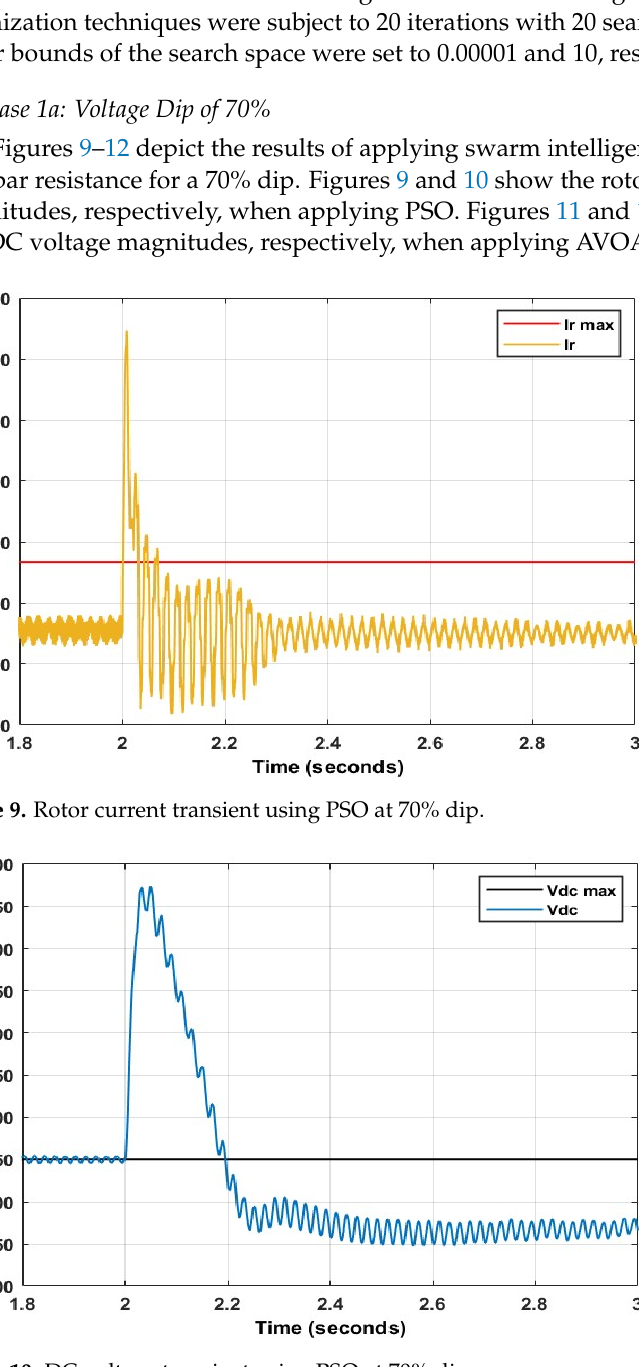
Figure 10. DC voltage transient using PSO at 70% dip.